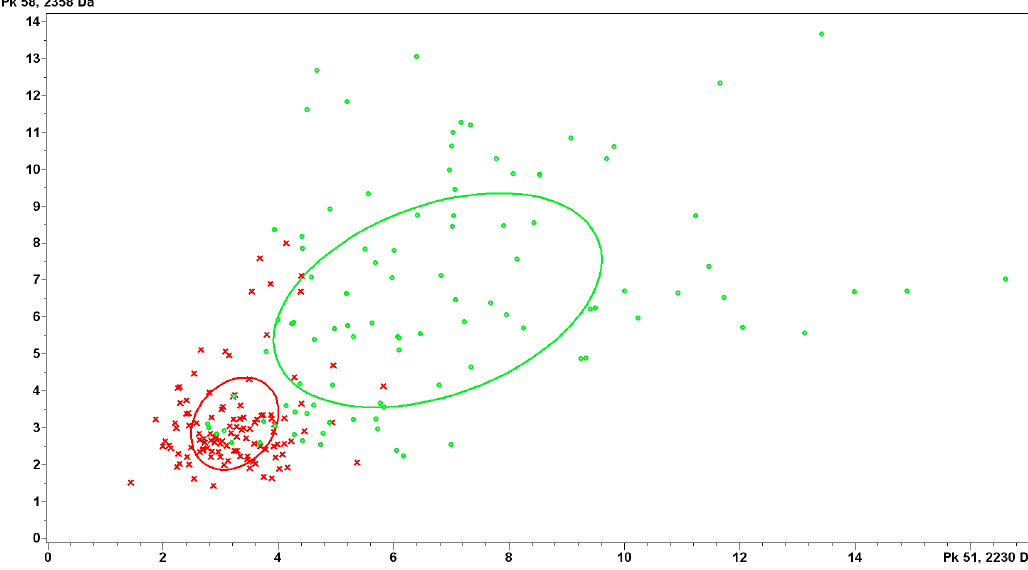
Figure 5. Discrimination features of peptides with m / z 2230 ( x -axis) and 2358 ( y -axis) between the patients with peritonitis ( red cross ) and control group ( green circle